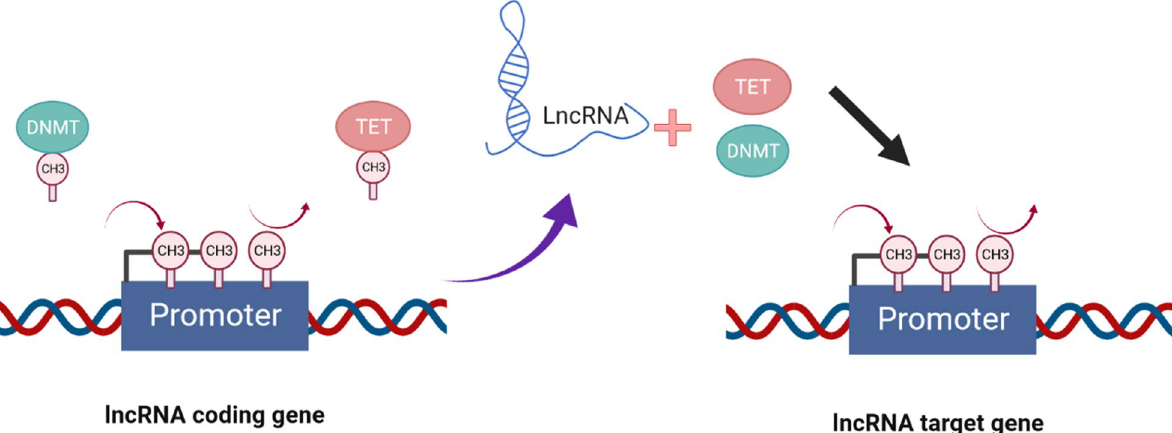
Fig. 1 Reciprocal interaction between lncRNAs and DNA promoter methylation. A The expression level of lncRNAs is controlled by DNA methylation and DNA-methylating enzymes in the promoter region of their codding genes. B Inversely, some lncRNAs can control the expression of various genes by interacting with DNA-methylating enzymes with different